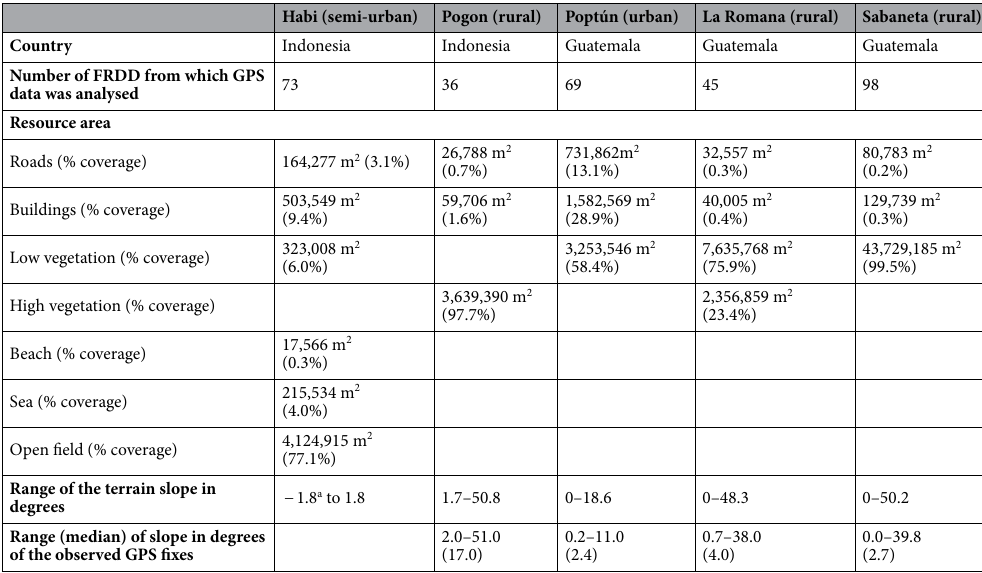
Table 1. Resource coverage and steepness of the terrain of the study sites to investigate habitat selection of 321 free-roaming domestic dogs (FRDD) in Guatemala and Indonesia. Building-like structures were identified in all study sites making up the “buildings” resource. “Roads” were also identified in all sites. Sparse vegetation and bushes present in all sites except Pogon were labeled as “low vegetation”, and dense forest-like vegetation present in La Romana and Pogon as “high vegetation”. In Habi, aside from the aforementioned resources, “beach”, “sea” and “open fields” were also identified. a Available habitat includes areas below sea